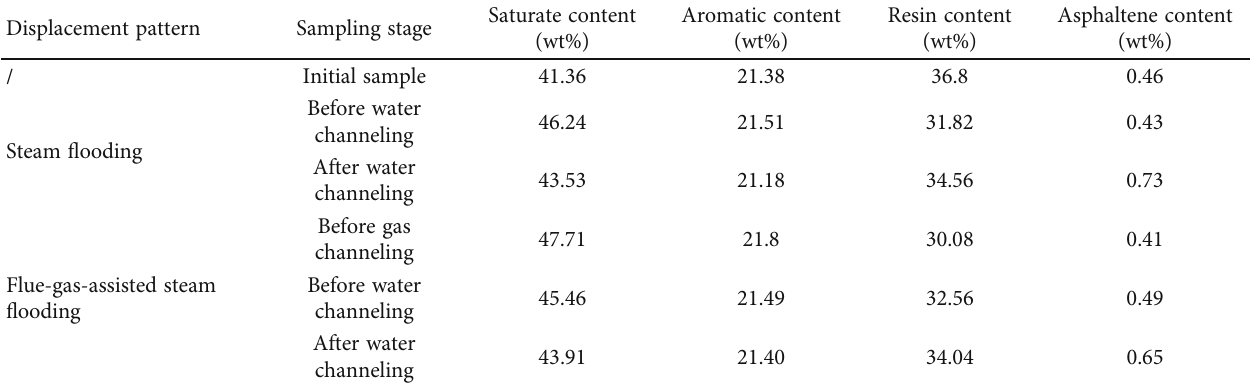
Figure 4: Variation curve of crude oil recovery and displacement pressure di ff erence with injection volume. Table 2: Four-component content data of produced crude